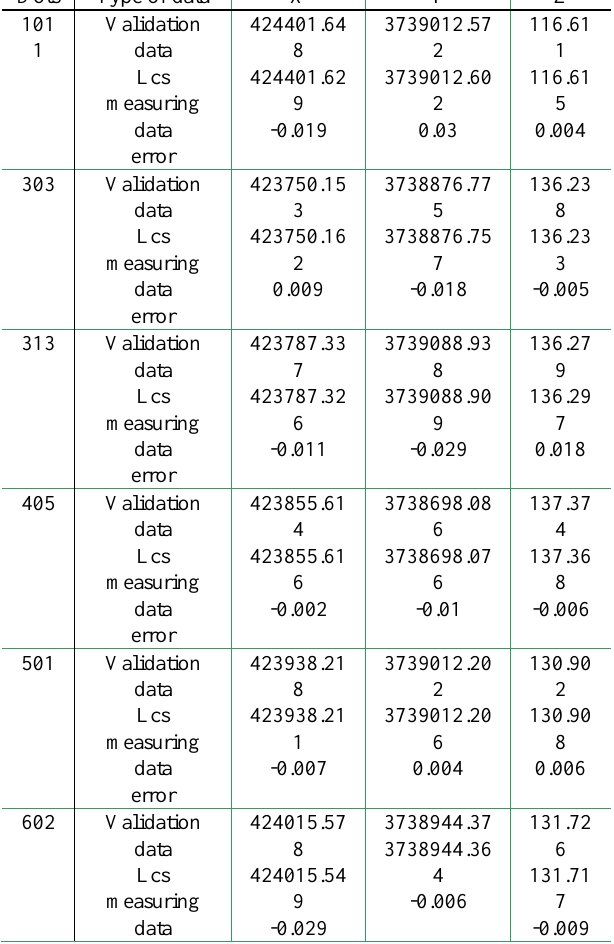
Figure 3. * DWG files into